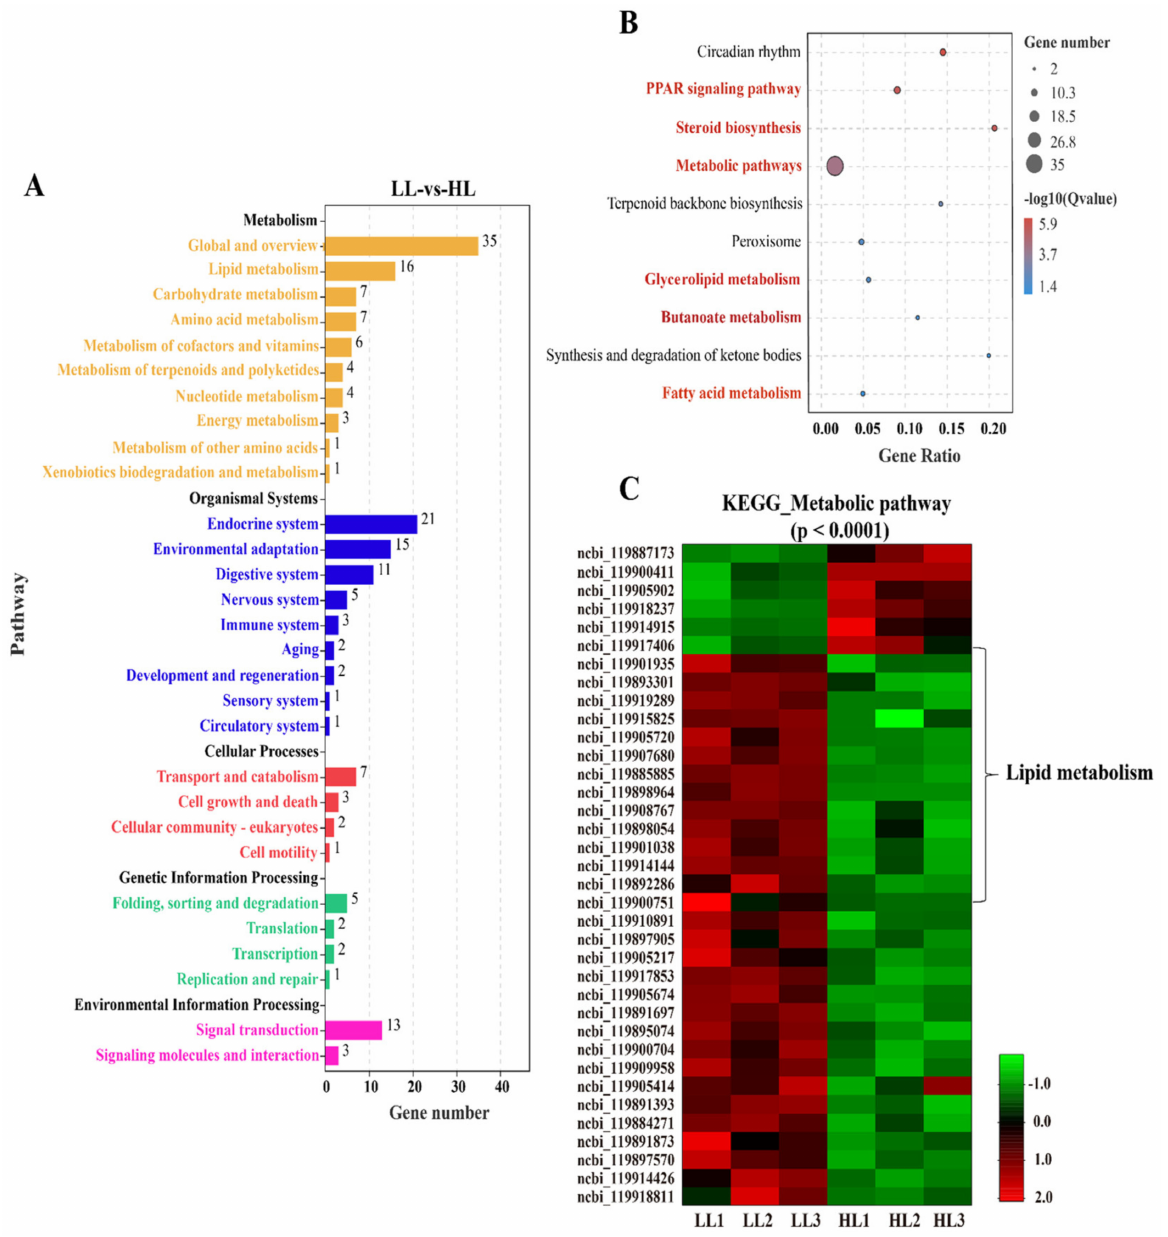
Figure 5. KEGG enrichment analysis for differently expressed genes (DEGs) in the liver of M. salmoides between the low-density group (LL) and the high-density group (HL). ( A ) DEG enrichment in the KEGG A Class and B Class. ( B ) The top 10 enriched KEGG pathways. ( C ) DEGs enriched in the metabolic